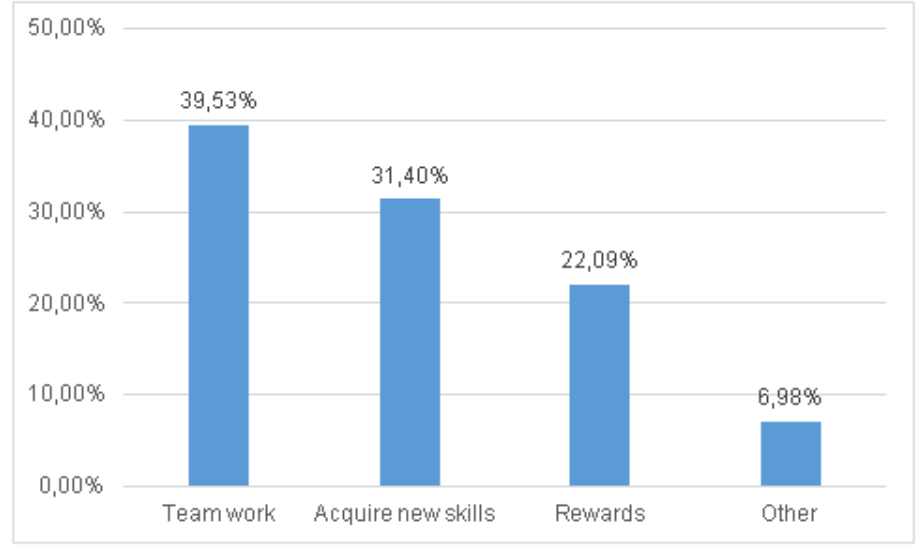
Figure 2. The incentives for participating in the